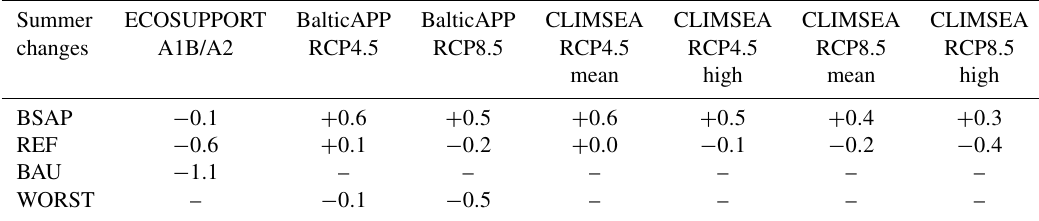
business as usual (BAU) or worst case (WORST). (Data sources: Meier et al., 2011b, 2021; Saraiva et al.,